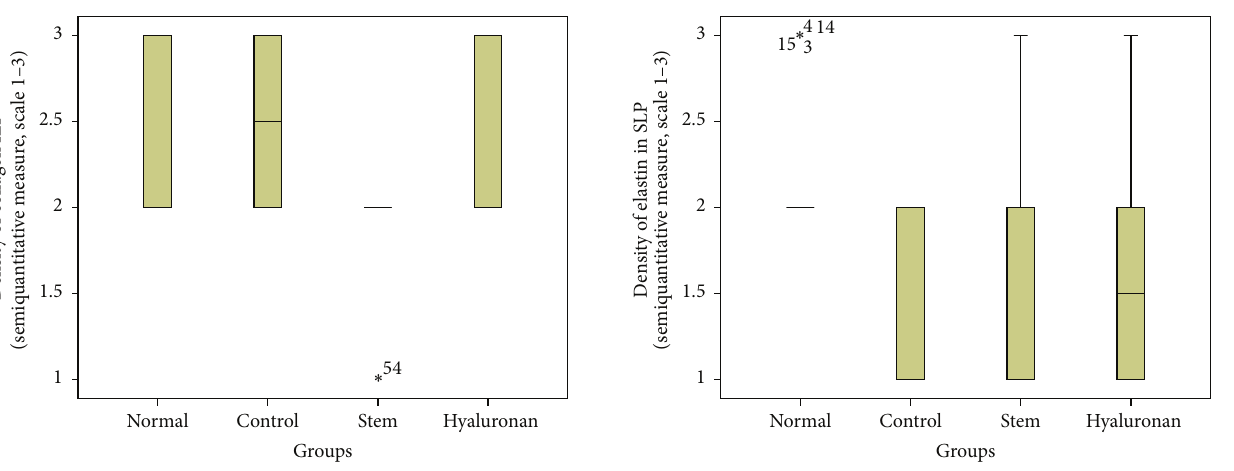
Figure 15: Density of collagen in the intermediate lamina propria (ILP). Normal = normal/control group, control = scarred/control group, stem = stem cell group, and hyaluronan = hyaluronan group.